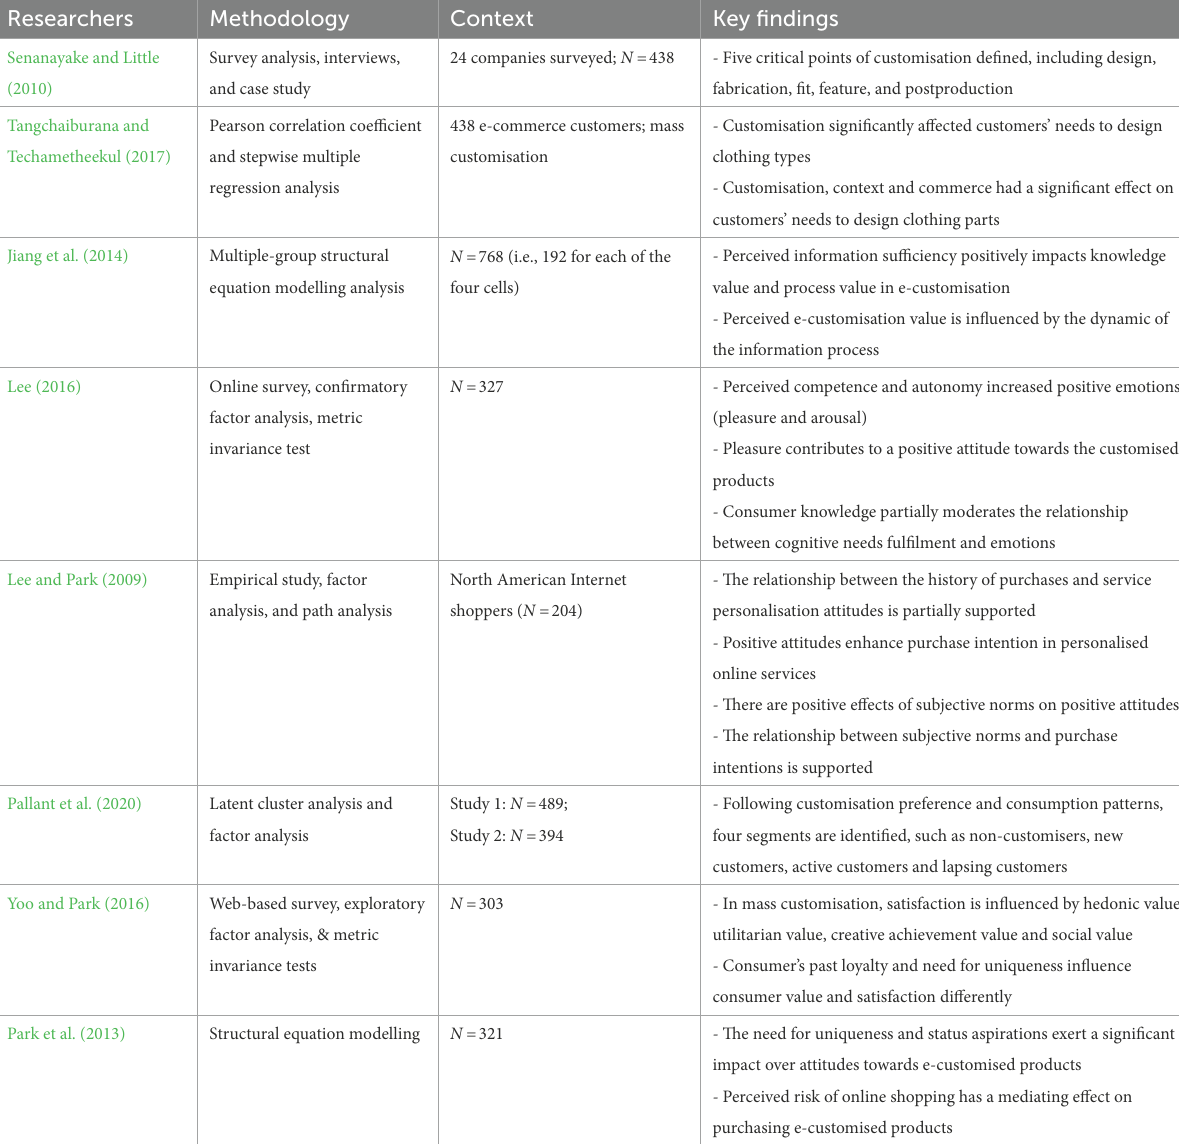
TABLE 1 Summary of the contributions of product e-customisation in